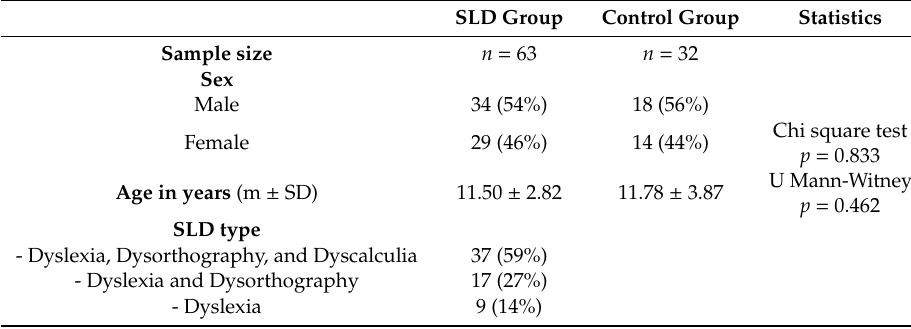
Table 1. Demographic and clinical